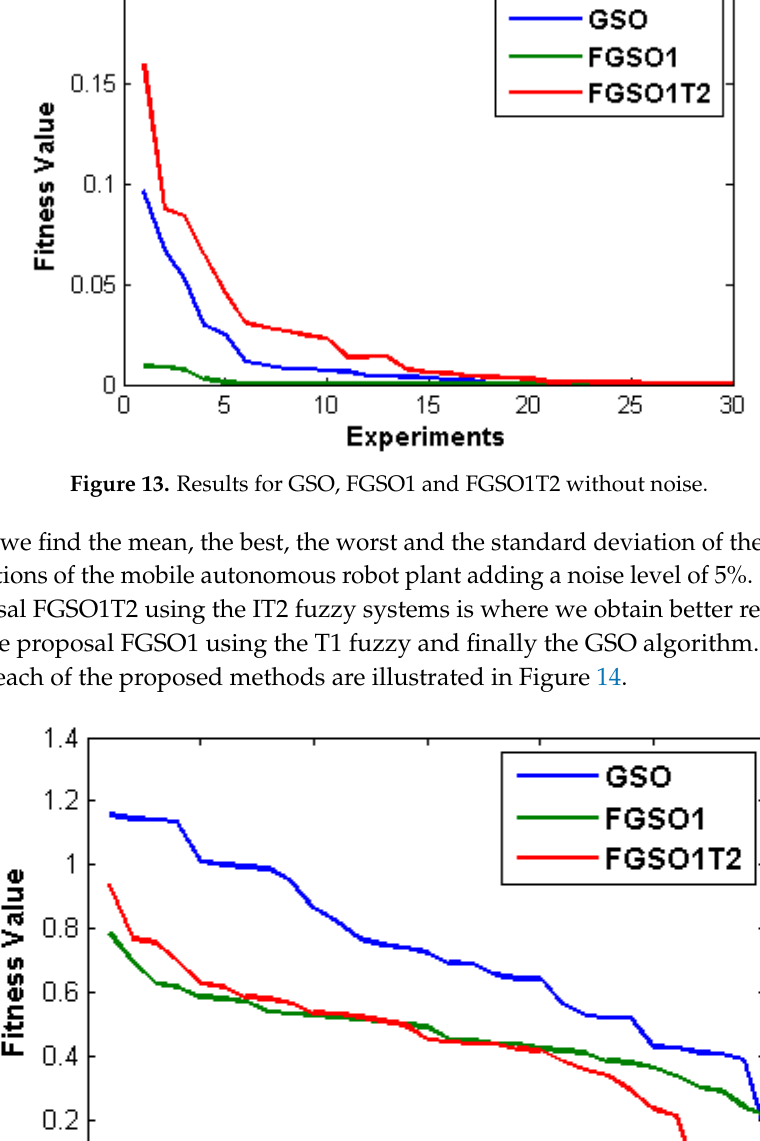
Figure 13. Results for GSO, FGSO1 and FGSO1T2 without noise. Table 3. Results with noise for GSO.